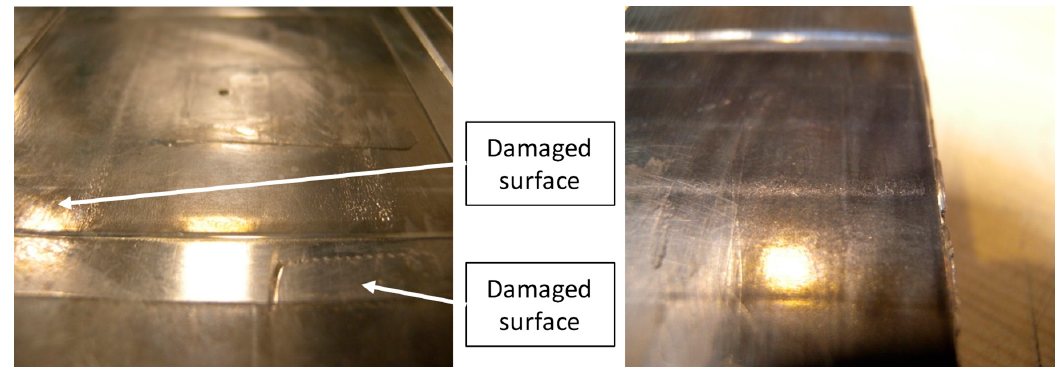
Figure 11. Example of damaged surface due to the use of aggressive parameters.